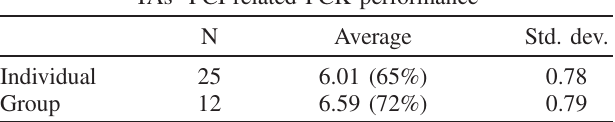
TABLE VII. FCI-related PCK performance of TAs in the individual and in the group PCK tasks: number of TAs or groups ( N ), averages (and percentage of maximum possible PCK score), and standard deviations (Std.